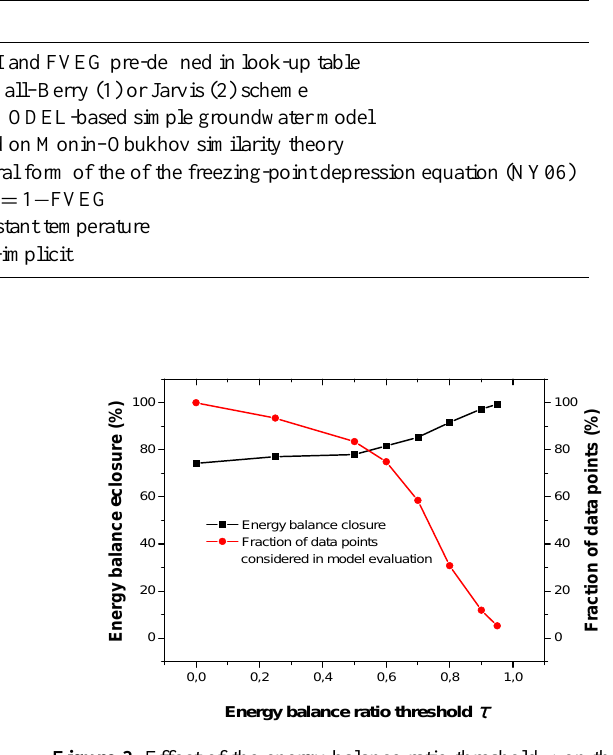
Figure 2. Prescribed dynamics of the green and total leaf area index and the fractional vegetated area used in NOAH-MP simulations. Note: until 15 June green and total leaf area index are the same.